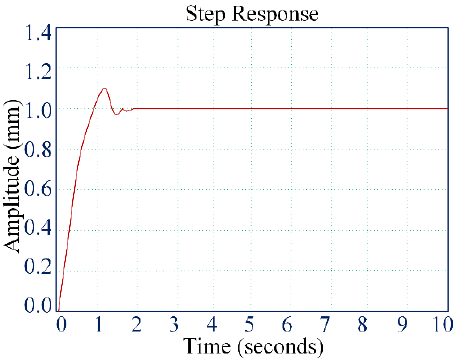
Figure 6. Step response curve of the EHS system after pole optimal configured control.